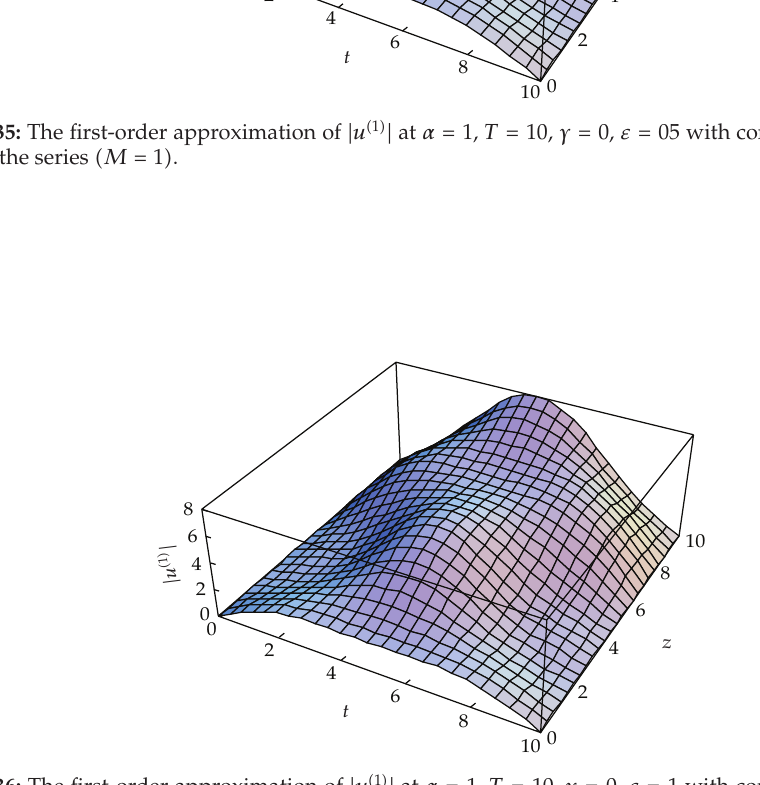
Figure 36: The first-order approximation of | u (cid:3) 1 (cid:4) | at α (cid:8) 1, T (cid:8) 10, γ (cid:8) 0, ε (cid:8) 1 with considering only one term in the series (cid:3) M (cid:8) 1 (cid:4)